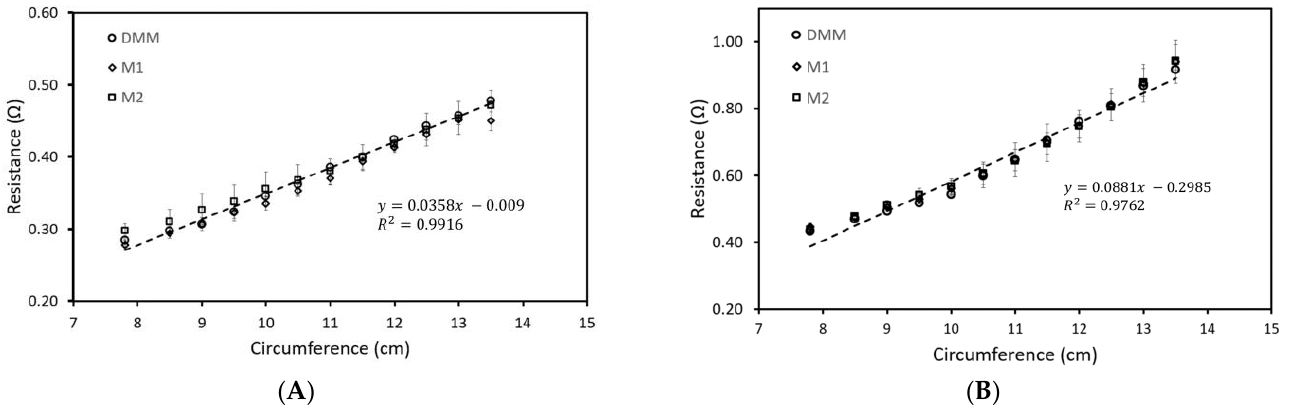
Figure 5. Verification of the resistance of T-sensor ( A ) and R-sensor ( B ) for increasing circumference (penile diameter) measured via ports M1, M2, and DMM.